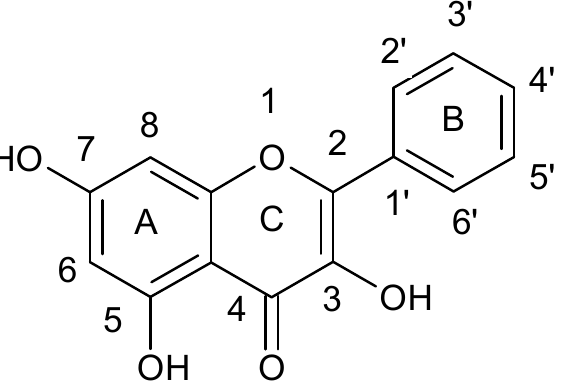
Figure 2. Chemical structure of galangin.